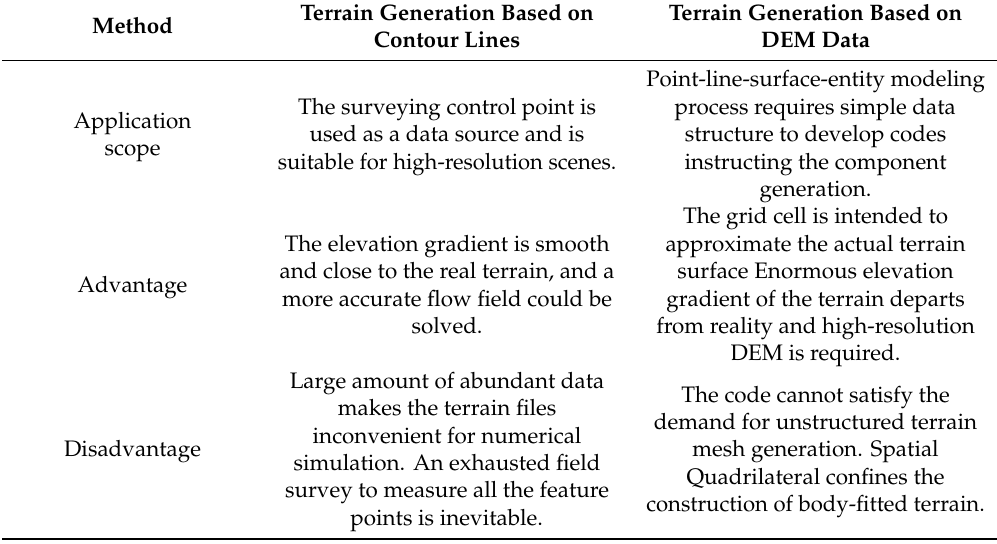
Table 2. Comparison of two terrain generation methods.